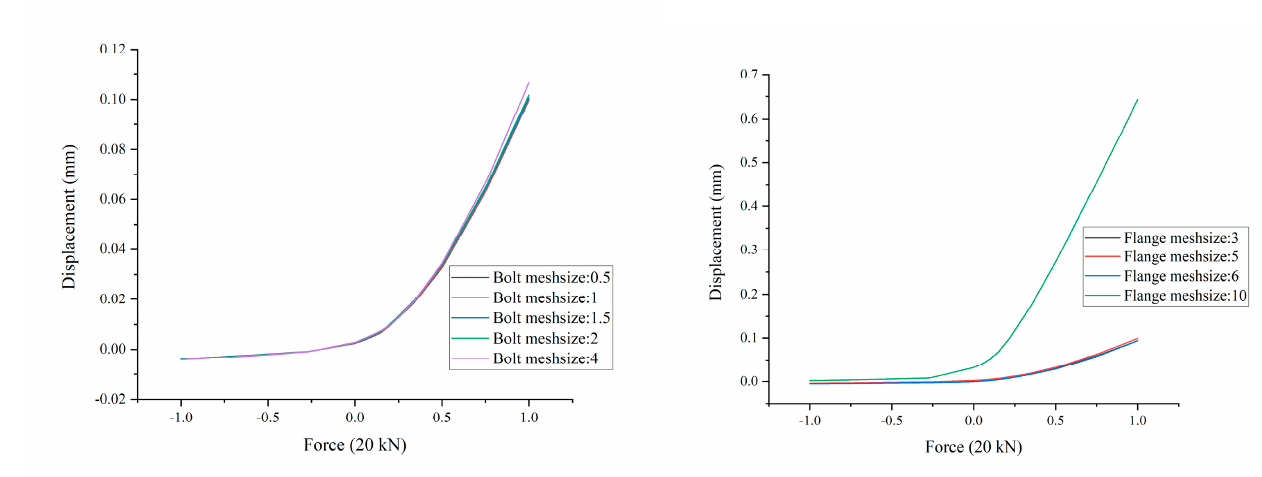
Figure 8. Force-displacement curve (varies with mesh size).